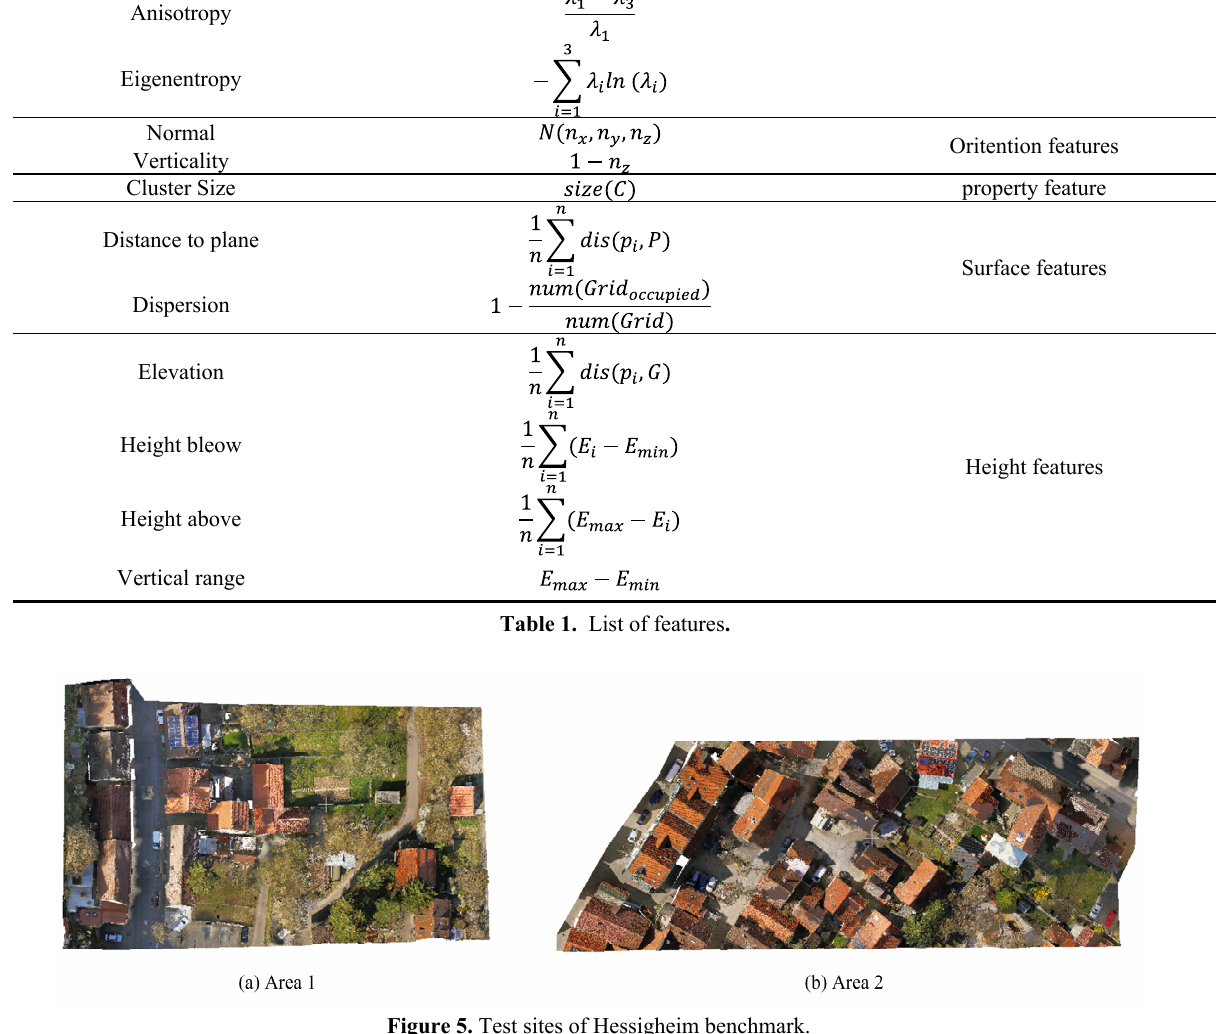
Figure 5. Test sites of Hessigheim